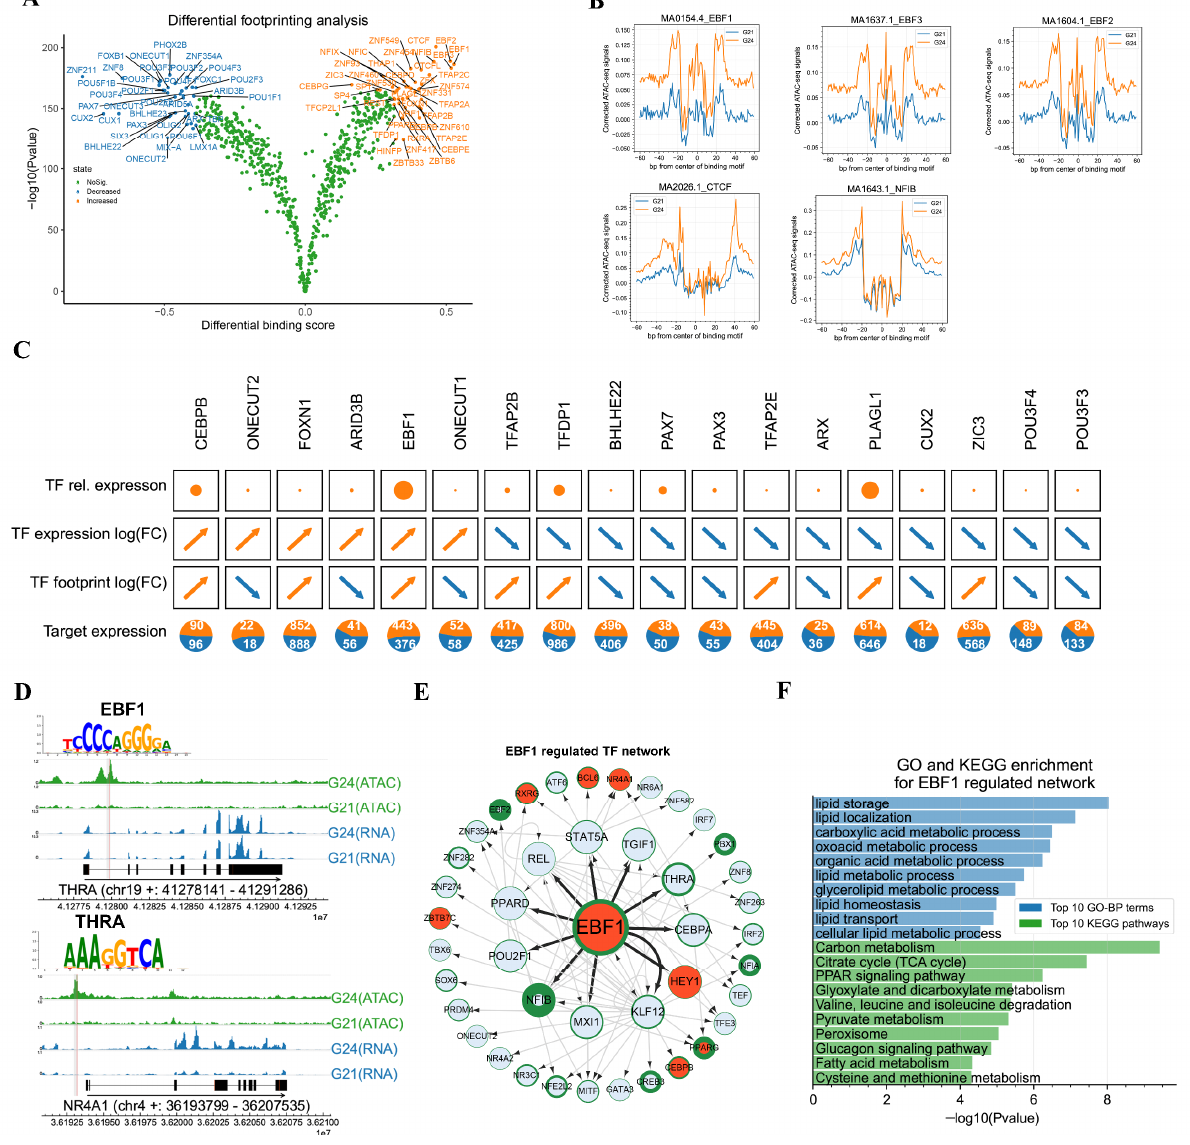
Figure 6. TF footprinting analysis identified the key TFs involved in the early development of FBAT. ( A ) Volcano plot showing the comparison of TF footprint between G21 and G24 across genome-wide ATAC-seq peaks. ( B ) Aggregated footprint plot of the top 5 TFs that increased their footprints. An aggregated footprint for all associated transcription factor binding sites is shown for each TF. Individual plots are centered around binding motifs. ( C ) Integrative analysis of relative expression, expression fold-change, footprint fold-change, and expression of the bound gene of key TFs during fetal BAT development. The area of the circle shows the relative expression of TF genes. An arrow pointing to the upper right corner shows an upregulated TF gene, or the increased footprint of one TF from G21 to G24. An arrow pointing to the lower right corner shows a downregulated TF gene, or the decreased footprint of one TF from G21 to G24. The orange and blue parts of a pie plot show the ratio of the upregulated bound genes and the downregulated bound genes of one TF, respec- tively. The numbers of the bound genes are marked in the corresponding part of the pie plots. ( D ) One path of the EBF1-regulated TF cascade network. The tracks show one path of the EBF1-regu- lated cascade network. The upper tracks show EBF1 binding to the promoter region of THRA and promoting THRA expression. The bottom tracks show the THRA binding to the promoter of NR4A1. The location of the peak is shadowed by grey color. The location of the binding site is shad- owed by red color. The binding motifs of EBF1 and THRA are shown at corresponding bind sites. ( E ) EBF1-regulated two-layer TF cascade network. Sizes of nodes represent the level of the network, starting with EBF1 (Large: EBF1, Medium: 1st level, Small: 2nd level). Nodes are colored based on